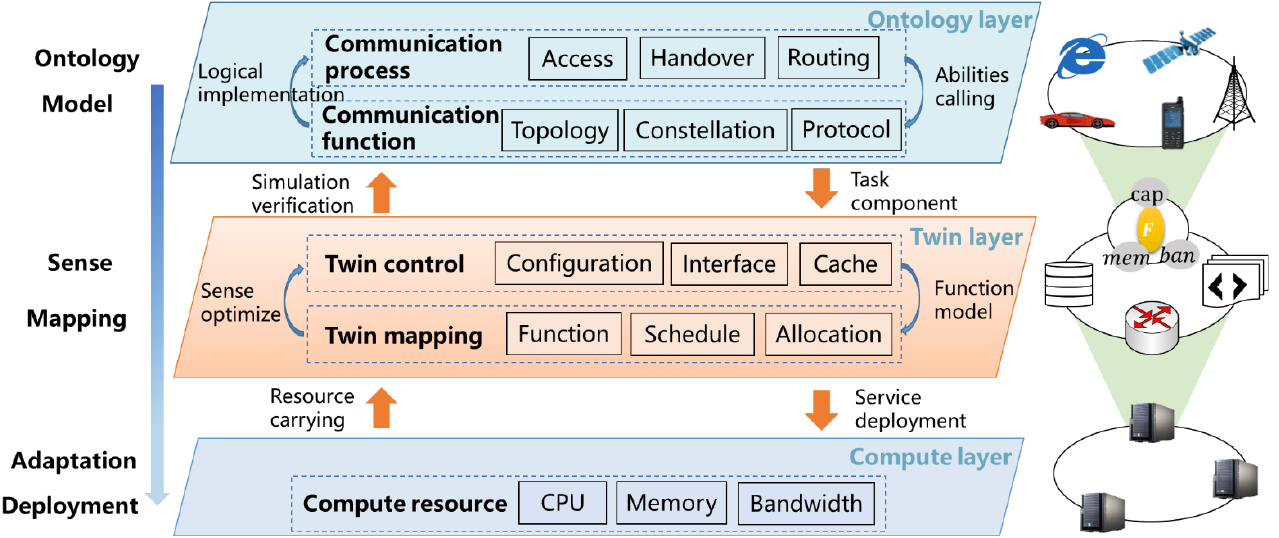
Figure 5. The decentralized adaptive development model.